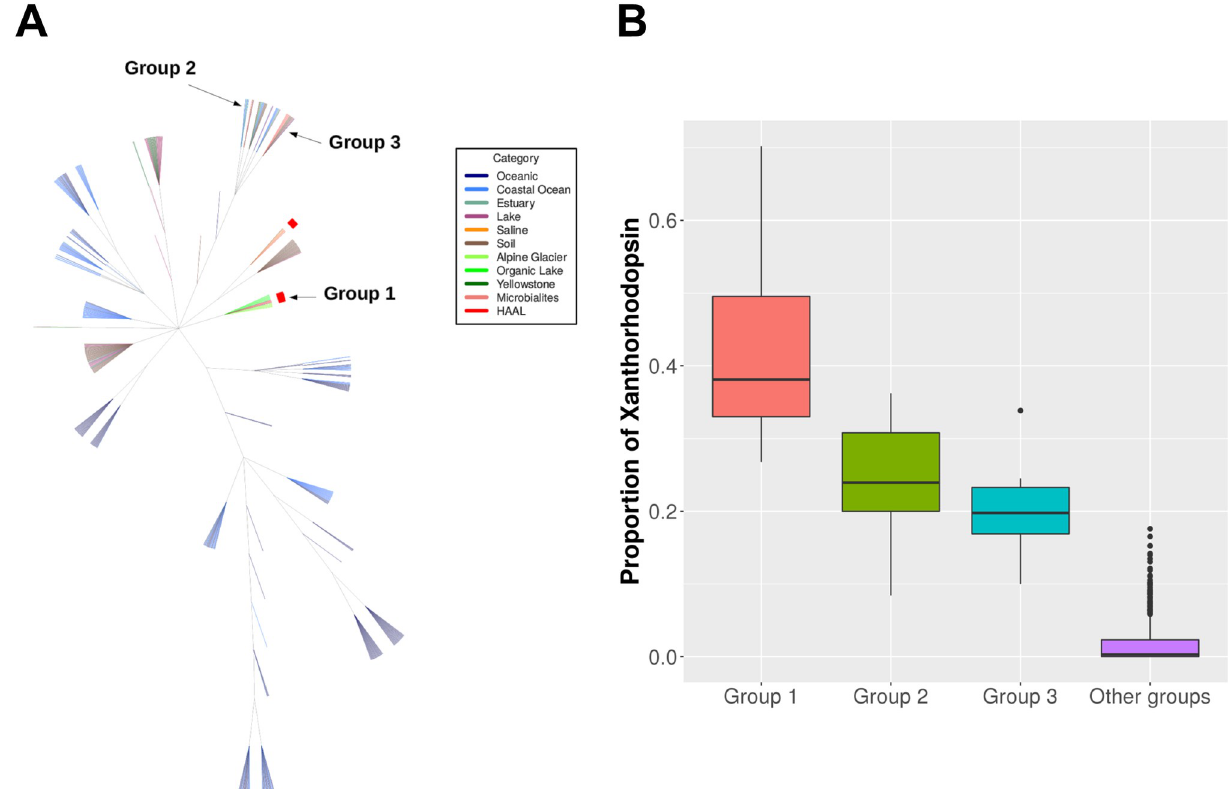
Fig 7. Xanthorhodopsin clusters. (A) Clustering of metagenomes from different environments based on rhodopsin type abundances. (B) Proportion of xanthorhodopsins in different groups.